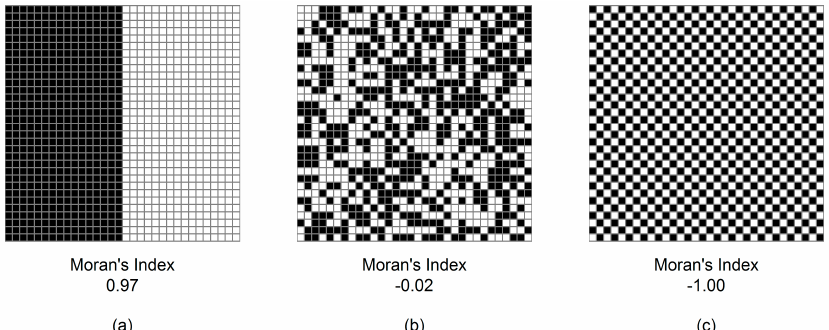
Figure 1. Example of Moran’s I values for different configurations of black and white cells on a regular lattice. ( a ) High spatial autocorrelation indicated by a Moran’s I value of 0.97, as black and white cells are (mostly) surrounded by equal cells. ( b ) Random pattern yielding a Moran’s I close to zero. ( c ) A perfectly dispersed pattern, where black and white cells do not share a single boundary, yields a Moran’s I of − 1.